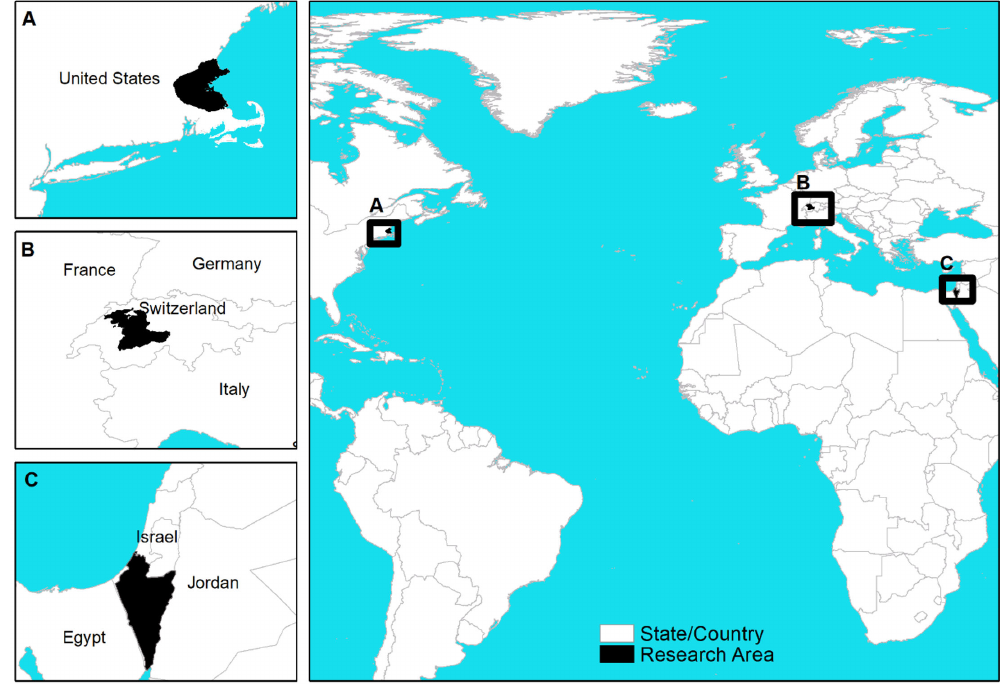
Figure 1. Research